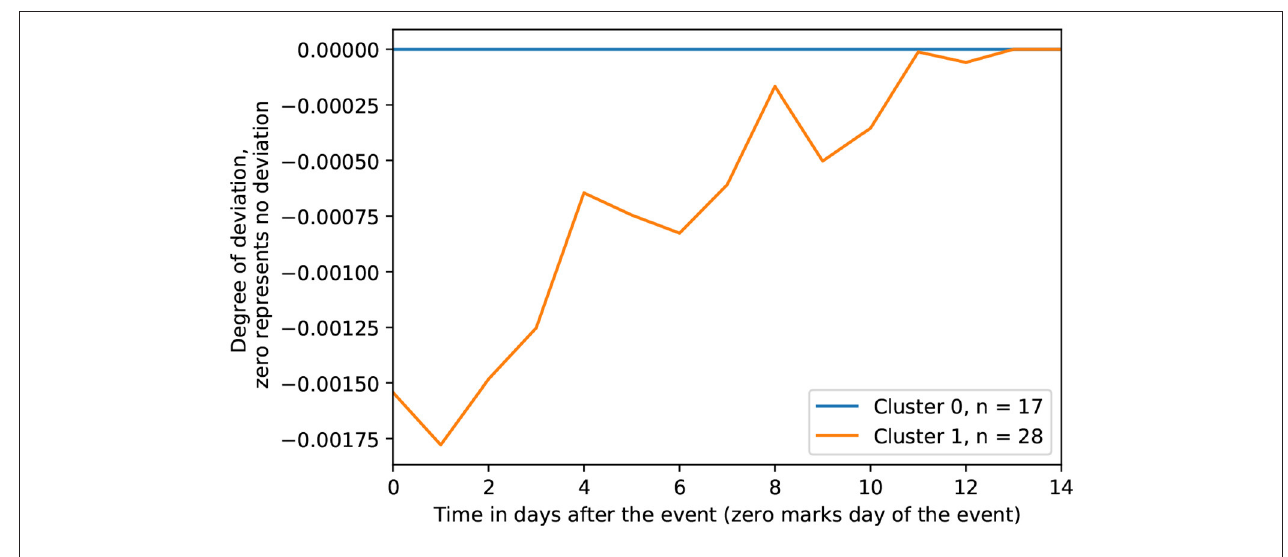
FIGURE 4 | Clustered response trajectories.